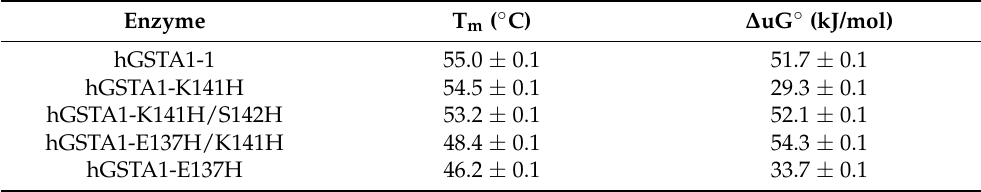
Table 4. Thermal stability of hGSTA1-1 and its mutants. Reported values represent the average of three replicates. Enzyme T m ( ◦ C) ∆ uG ◦ (kJ/mol)